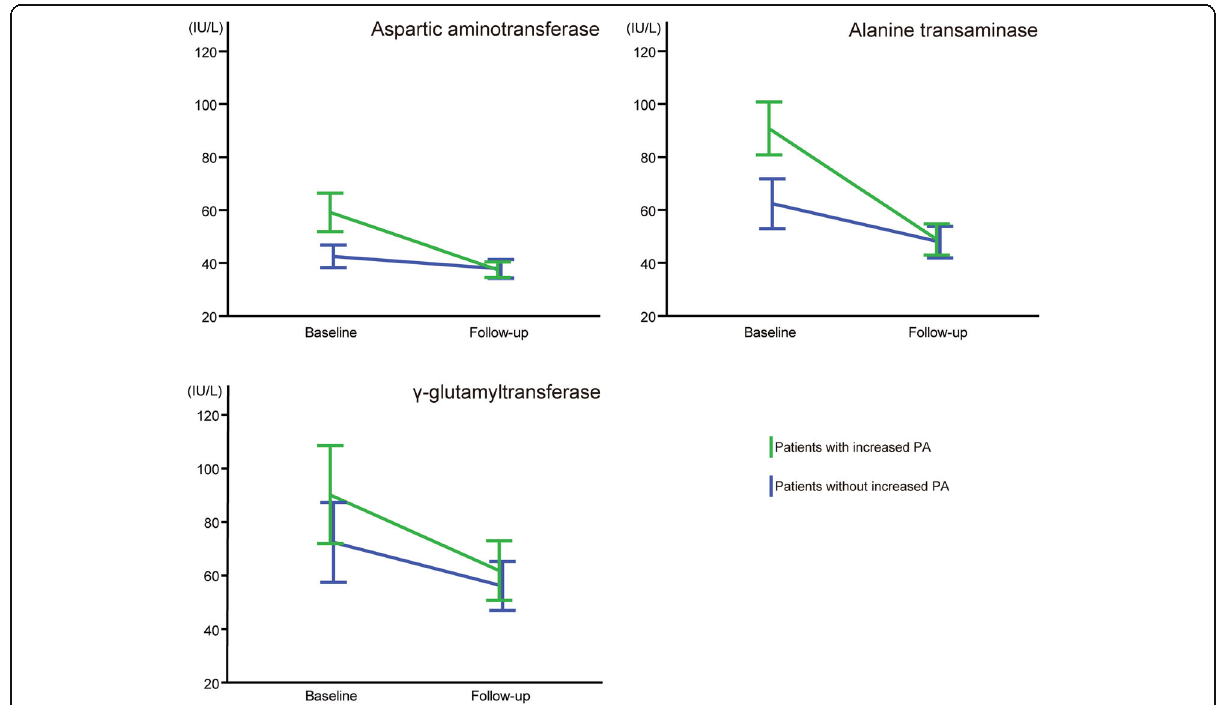
Fig. 1 Levels of aspartic aminotransferase, alanine transaminase, and γ -glutamyltransferase between the physical activity increase and physical activity non-increase groups. Two-factor repeated measures analysis of variance. The green line indicates patients with increased physical activity (PA), whereas the blue line indicates patients without increased PA. The error bar presents the standard error in both groups. There was